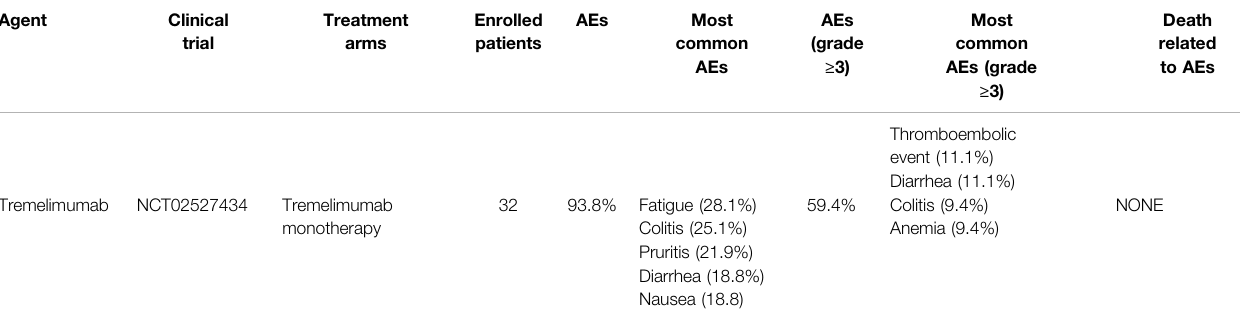
TABLE 3 | ( Continued ) Key clinical trials ’ safety data of ICIs in patients with mUC.